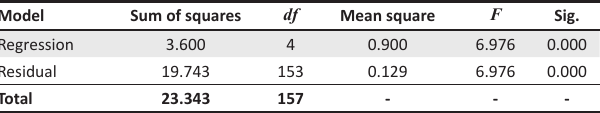
TABLE 2: F -Statistics test. Model